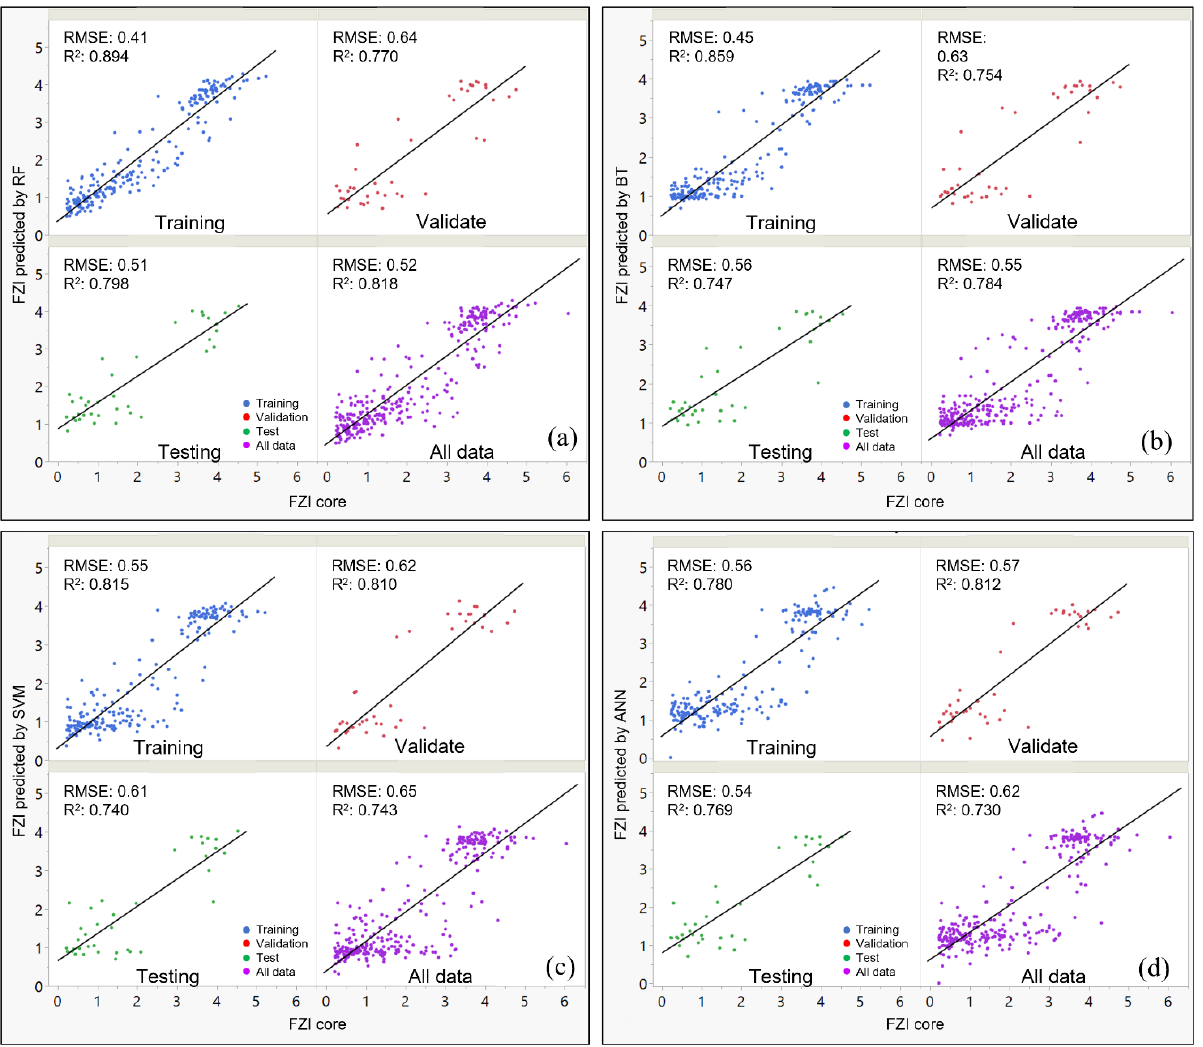
Figure 12. The cross plots between FZI cores versus FZI prediction of 4 methods of supervised machine learning. For each method we can get the results: Training, validate and testing: ( a ) Random Forest (RF); ( b ) Boosted tree (BT); ( c ) Support vector machines (SVM) and ( d ) Neural Boosted (ANN).